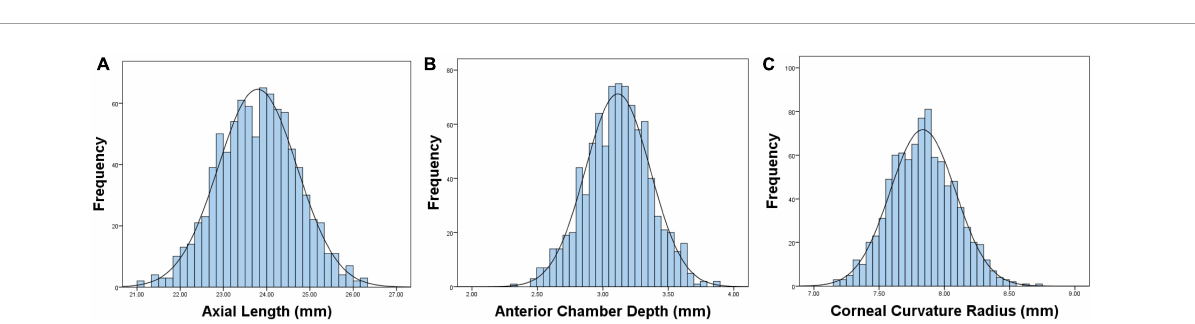
FIGURE3 Graphs showing the distributions and fitted normative curves of ocular biometric parameters: axial length (AL) (A) , anterior chamber depth (ACD) (B) , corneal curvature radius (CCR) (C)